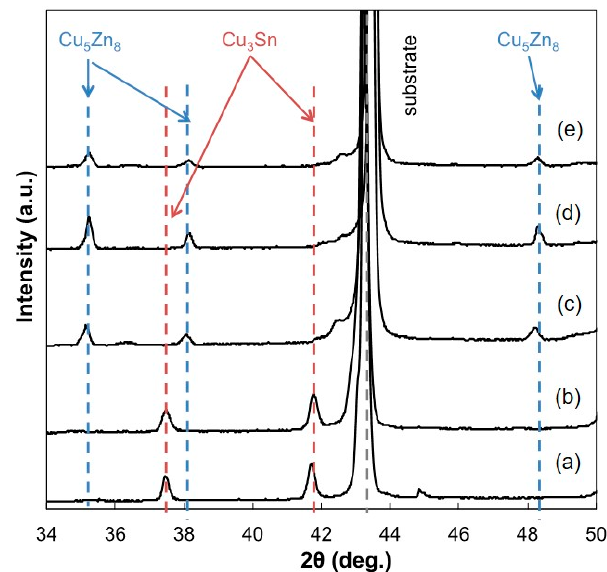
Figure 12. X-ray diffraction patterns which were obtained from the fracture surfaces of the jointed Cu rods after the tensile test. (Zn content: ( a ) 0 at.%, ( b ) 20 at.%, ( c ) 35 at.%, ( d ) 53 at.%, ( e ) 66 at.%).